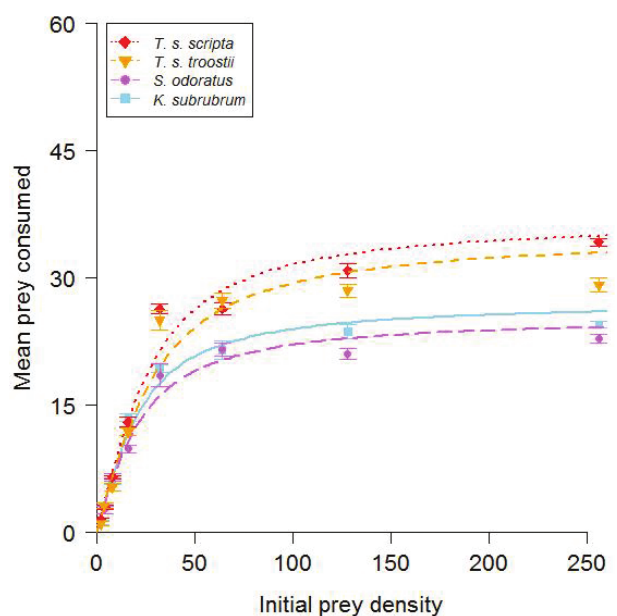
Figure 1. Functional responses of T. s. scripta , T. s. troostii , S. odoratus and K. subrubrum towards G. pulex prey. Values are mean ± SE.